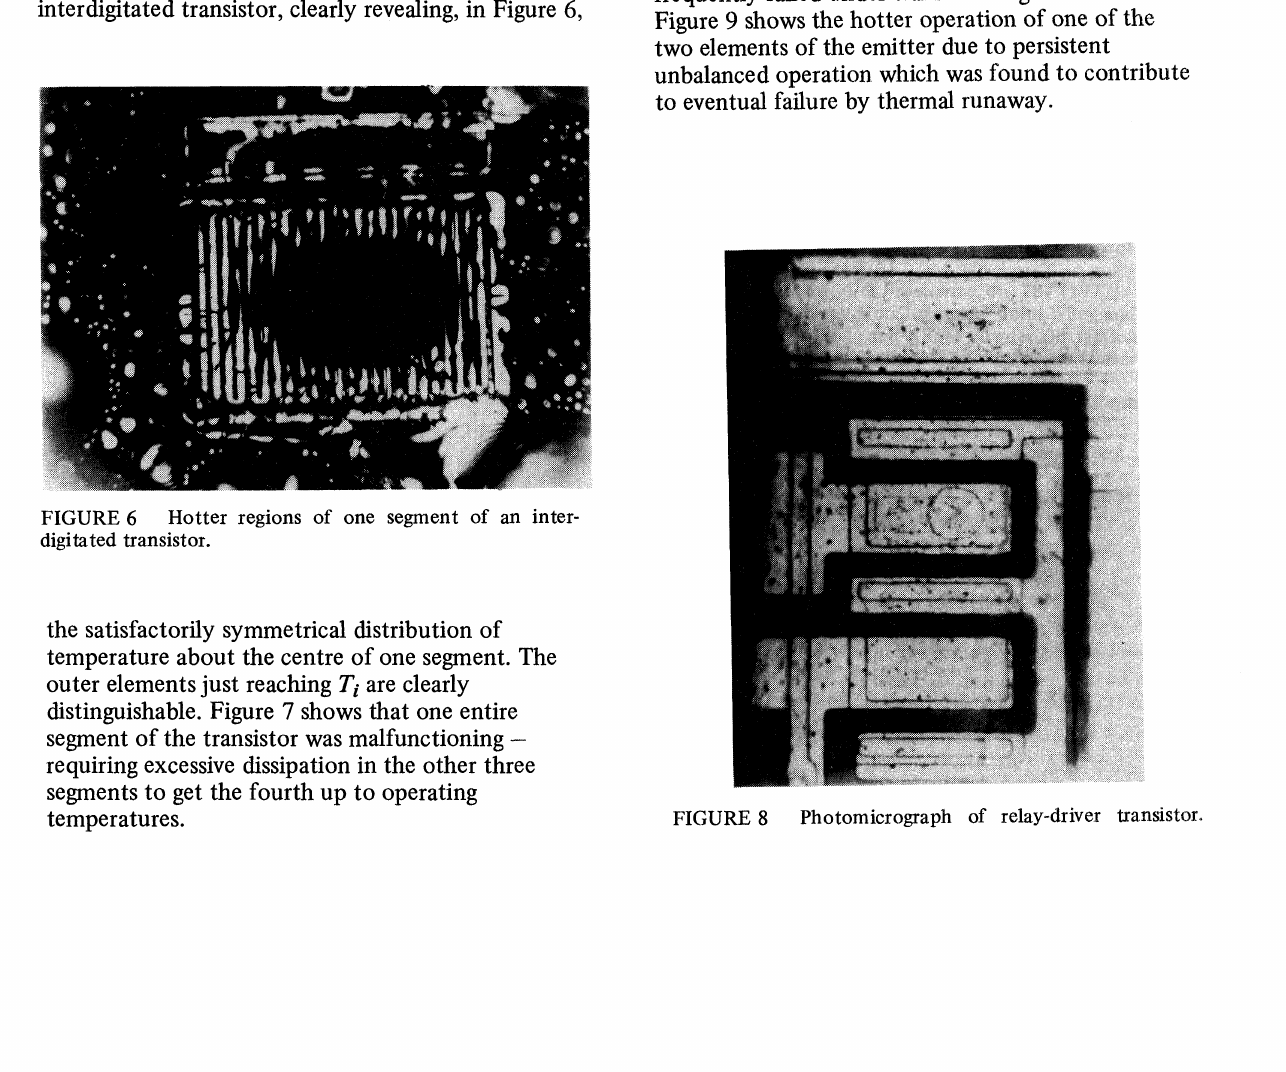
Malfunction revealed in one segment of tlhe transistor.